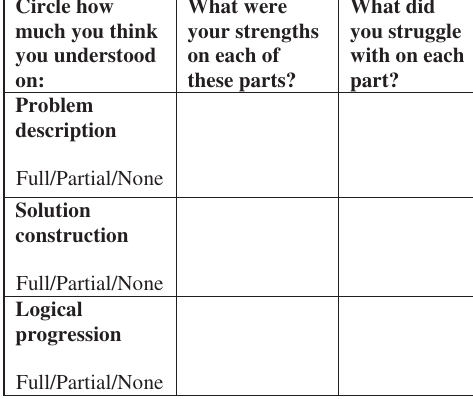
FIG. 1. Example of a context-rich problem provided during the laboratory group problem solving exercise.